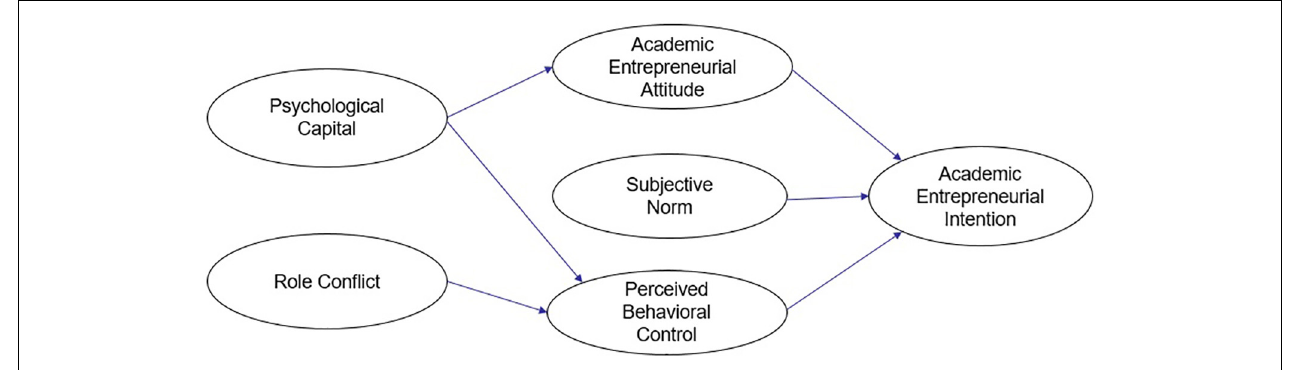
FIGURE 2 | Research framework.